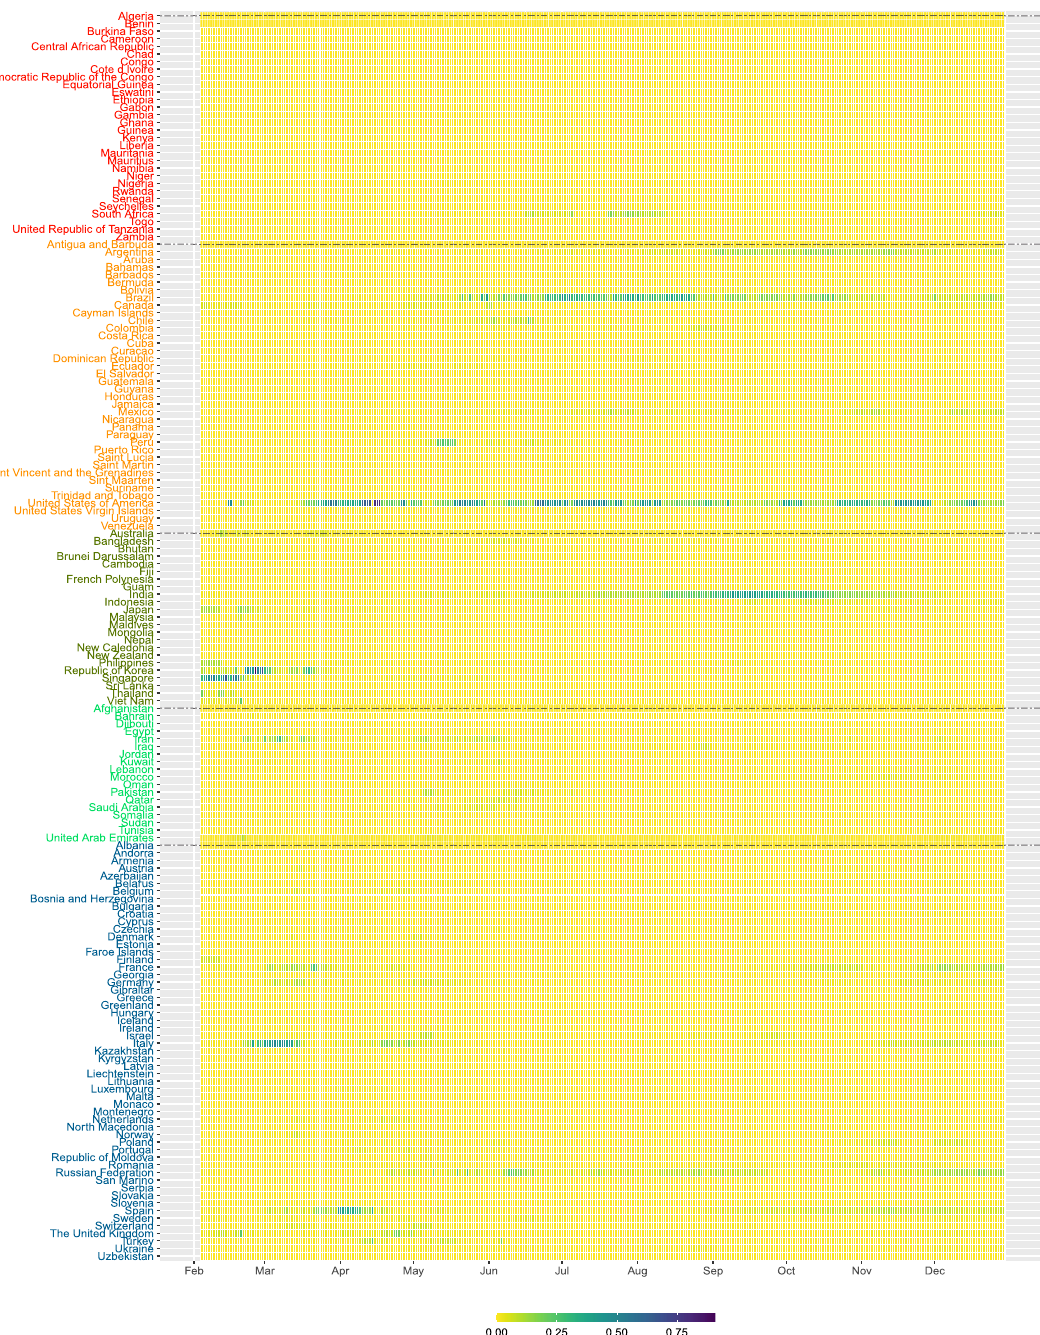
Figure 4 (right bottom pannel) gives the risk contributions of Africa, America, Asia, Eastern Mediterranean and Europe by grouping the g it , the risk contribution based on the second pandemic risk score S 2 t in Eq. (9). Since S 2 t is deduced from the number of possible interactions between people of a susceptible population and people of an infected population, the number of confirmed cases will play an important role in determining the risk contribution g it . From Fig. 4, the pandemic risk based on S 2 t was contributed mostly by Asia in February 2020, and mostly by Europe and America in March and April 2020. After April, the risk contribution from America climbed up to about 0.5, and exceeded 0.75 in July 2020. In September and October 2020, the risk contribution is dominated by Asia. The risk contribution of America and Europe are at high levels in November and December 2020, when the winter comes. Figure 6 presents the heatmap of g it . This risk contribution reflects the severity of the COVID-19 pandemic risk from each country and thus is a viable measure for guiding us on the pandemic